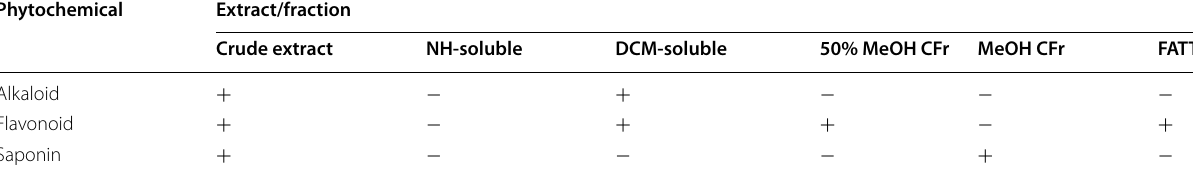
Present; Absent + = − = NH n-hexane; DCM dichloromethane; 50% MeOH CFr 50% methanol chromatographic fraction; MeOH CFr 100% methanol chromatographic fraction; FATT flavonoid aglycone fraction of Tribulus terrestris leaf extract